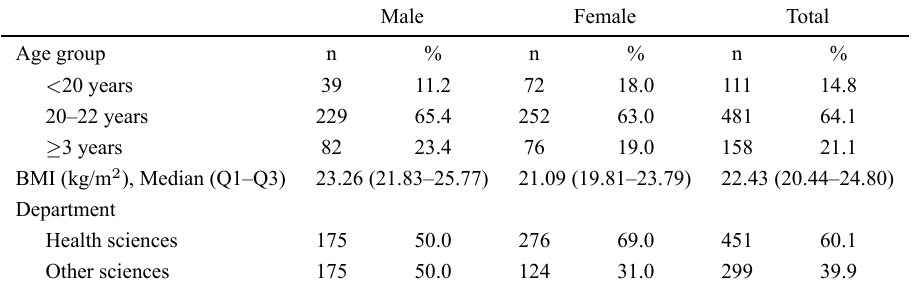
Table 1. Descriptive statistics for demographic characteristics of the participating university